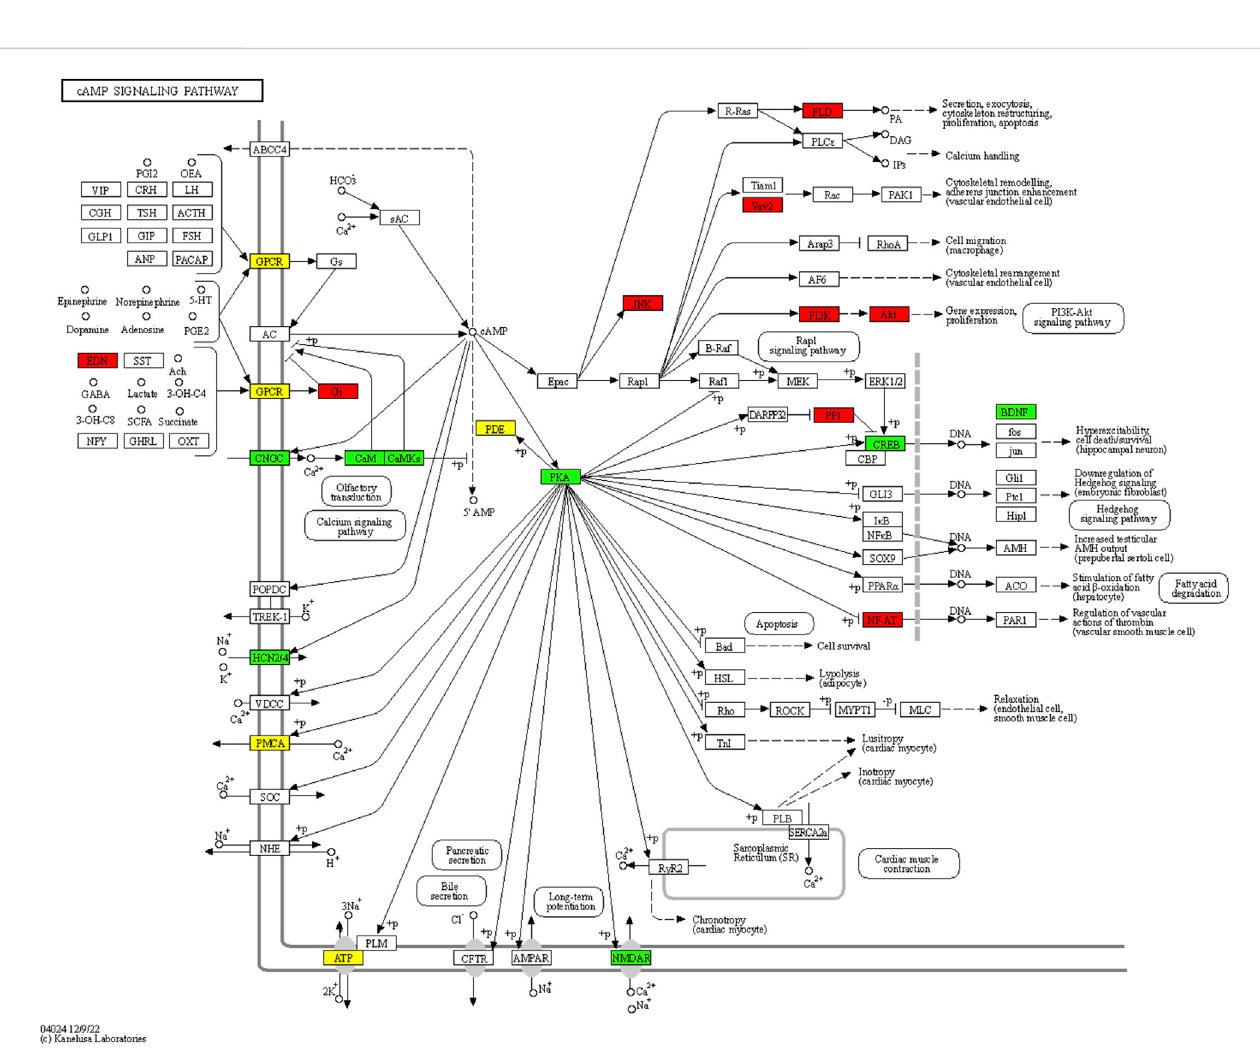
FIGURE 5 Differentially methylated genes in cAMP signaling pathway. Red: genes were hypermethylated; green: genes were hypomethylated; yellow: genes were both hypermethylated and hypomethylated.